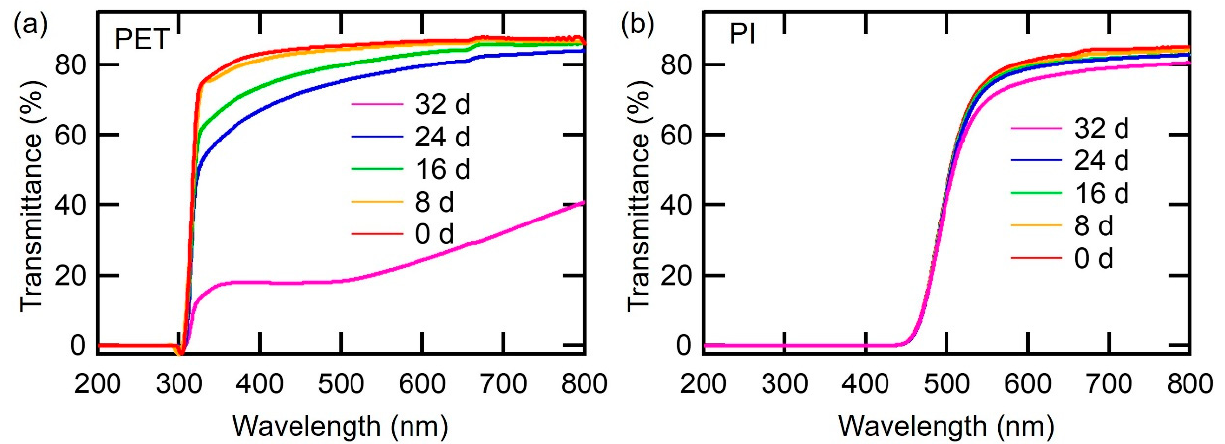
Figure 4. UV-Vis transmission spectra of ( a ) PET and ( b ) PI films after aging for various times.